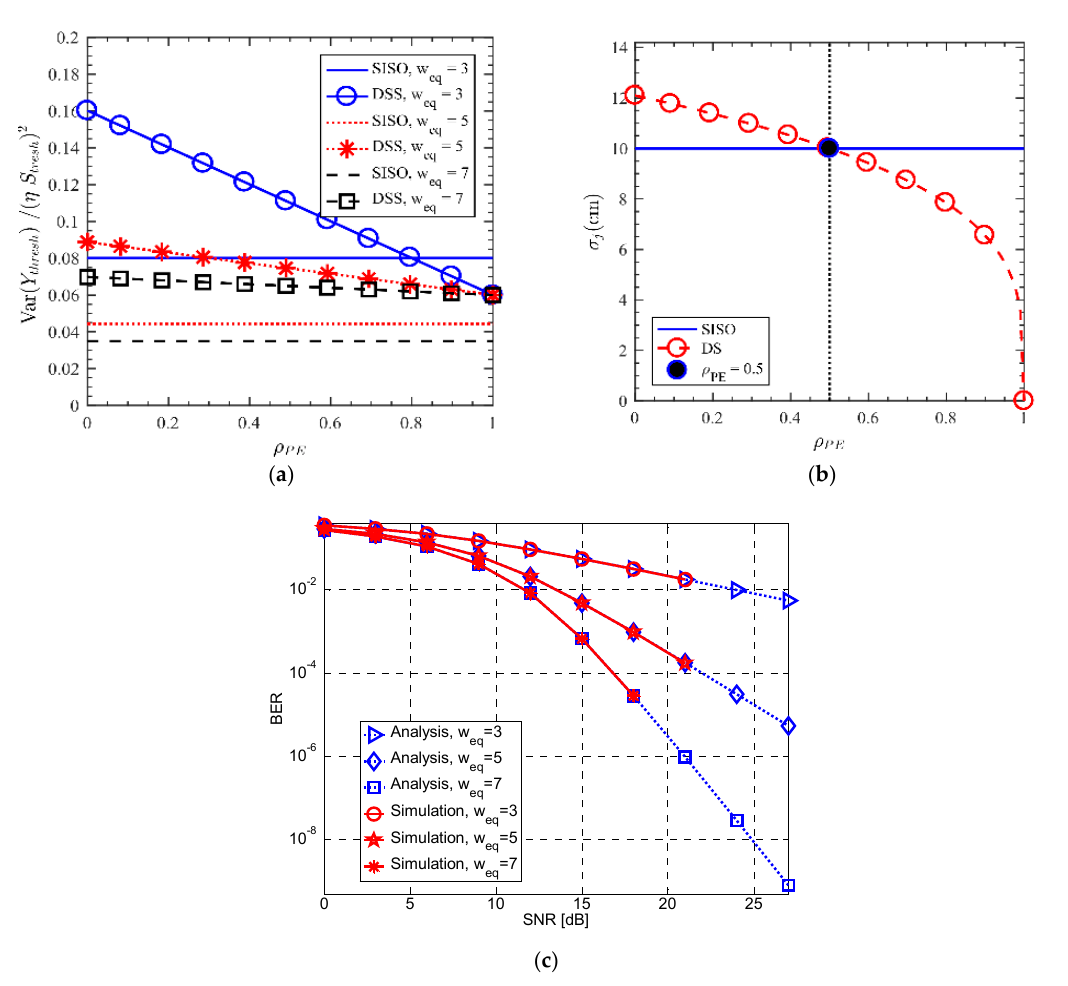
Figure 4. Single-input single-output (SISO) and differential signaling scheme (DSS) based free-space optical (FSO) links with pointing errors (PE): ( a ) the normalised variance of detection threshold level (DTL) versus the correlation coefficient of the channels; ( b ) the jitter standard deviation of the equivalent DSS PE vs. correlation coefficient ρ PE , for the SISO system with DSS and for a = 10 cm, and w = 100 cm, and ( c ) bit-error-rate (BER) against signal-to-noise ratio (SNR) for σ j = 1, s = 1, A 0 = 1, and different values of w eq with unit of